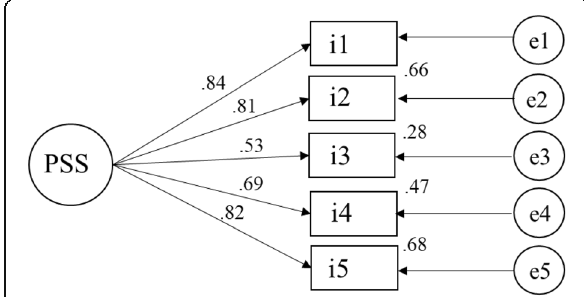
Fig. 1 Confirmatory factor analysis of one-factor model of the PSS among Portuguese